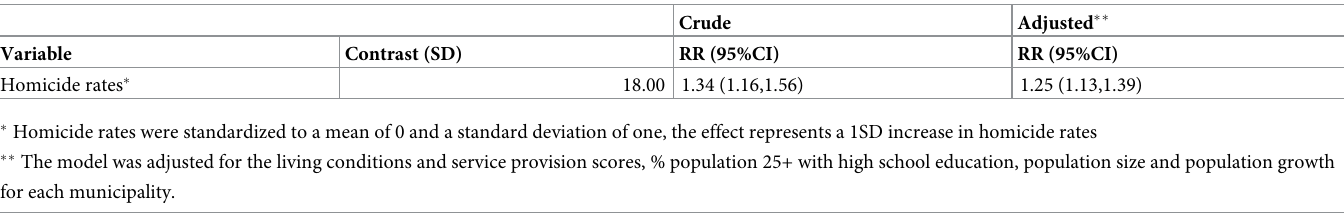
Table 4. Rate ratios of the association between municipality homicide rates and municipality HIV rates for